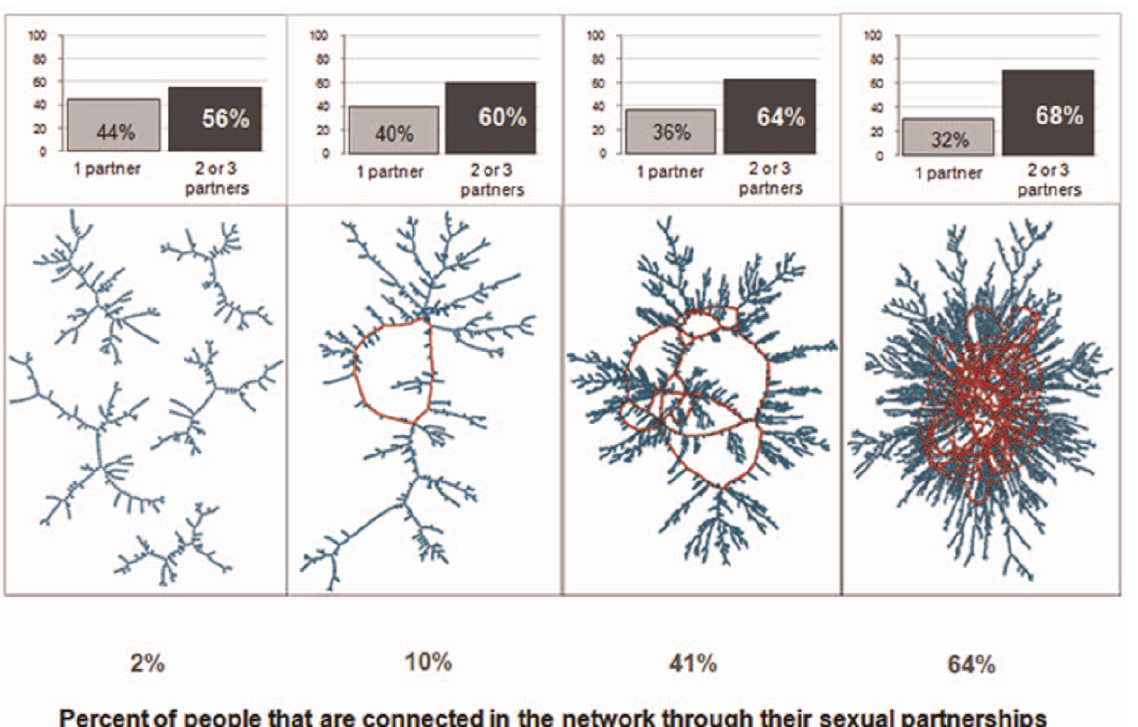
Figure 1. Growth of the largest component in large networks at the threshold: This figure demonstrates the rapid growth of the giant component in large networks near the threshold level of concurrency. The top row shows histograms of the momentary degree distribution for networks at mean degree 1.68, 1.74, 1.80 and 1.86, corresponding to 56, 60, 64 and 68 percent of sexually active persons having concurrent partners. The bottom row gives a visualization of a typical largest component. We can see that the percentage of the population in the largest component jumps rapidly from 2% to 64% with a very small increase in mean degree (0.2 of a partner, 12% more persons with concurrent partnerships).